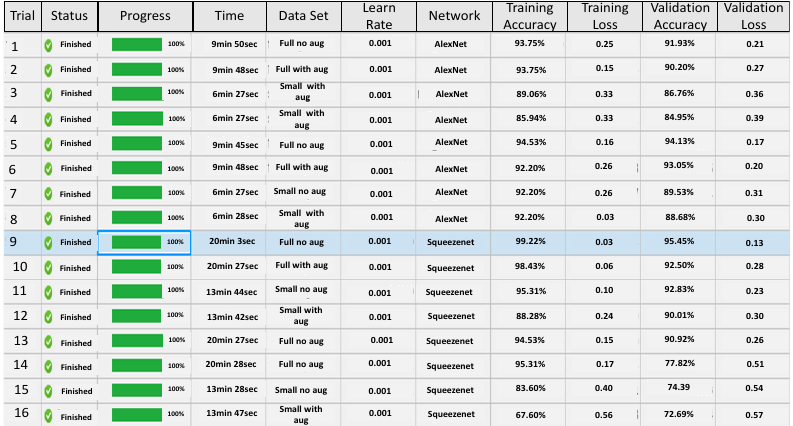
Figure 10. Figure showing application of network optimization workflow on AlexNet and SqueezeNet using the database of images and trial runs for initial learning rateparameter optimiza- tion. The blue box highlights the best case with optimum parameters selected from the experimental design.